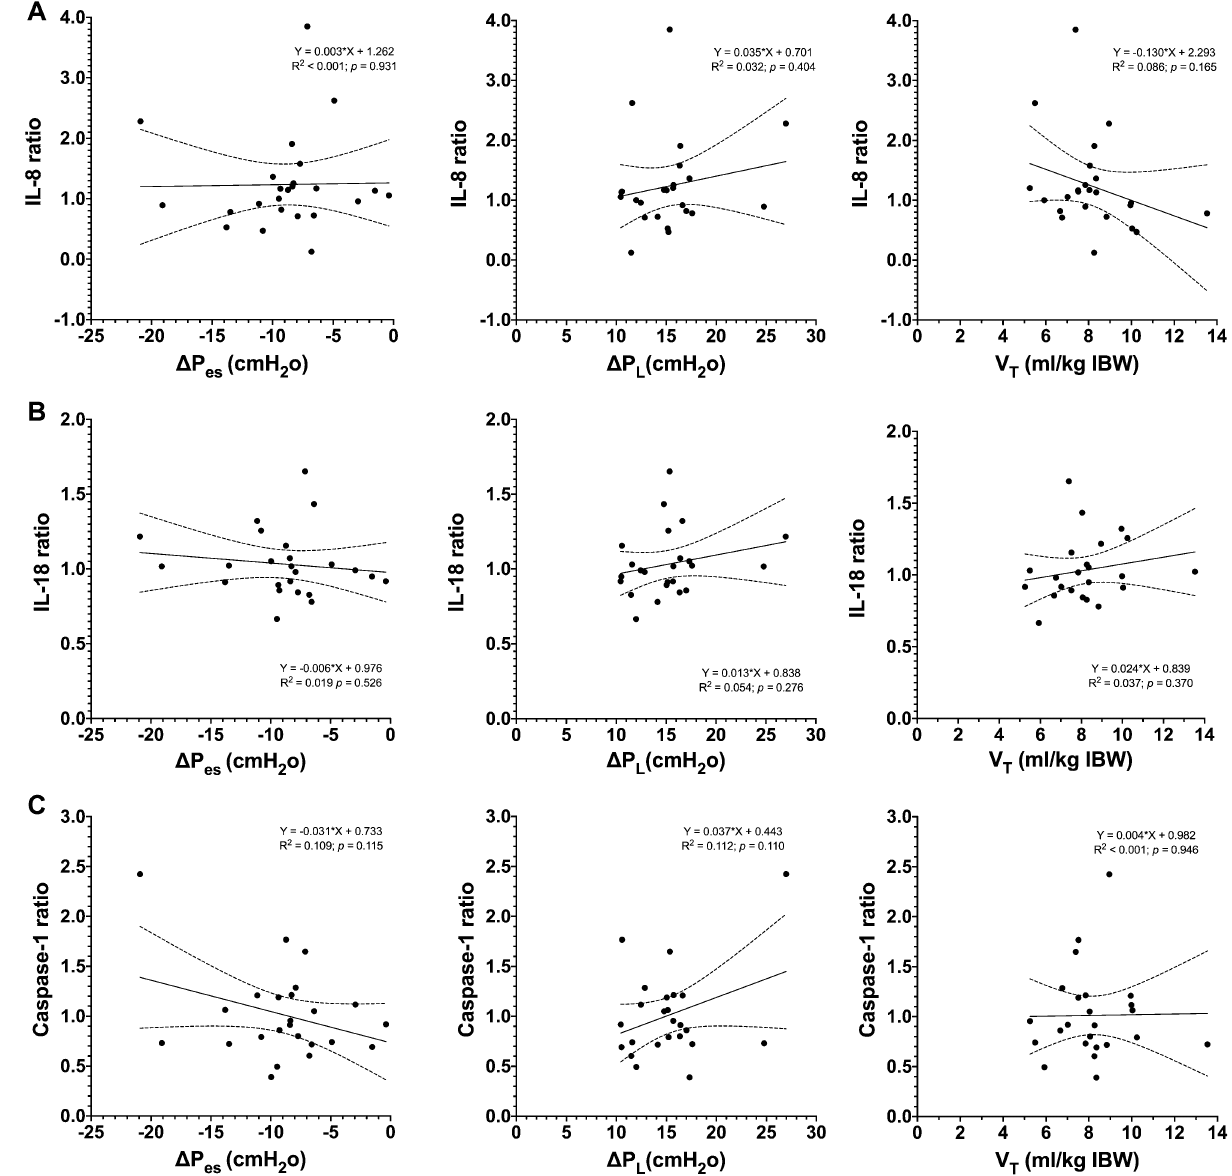
Figure 3. Scatter plots and regression analysis between ( A ) IL-8, ( B ) IL-18, ( C ) Caspase-1 ratios, and respiratory variables. Biomarker ratio [(biomarker at T 4 )/(biomarker at T 0 )] and the mean values by patient of ΔP es , ΔP L and V T , through the 4 h period of observation, were obtained for each patient ΔP es : mean of negative deflection of esophageal pressure (P es ) from the onset of inspiratory effort during the ventilatory cycle; ΔP L : mean of tidal change in transpulmonary pressure. Only the association between ΔP es and ΔP L and the pendelluft 2 0.202 and p- value = 0.047). Several patients presented pendelluft of higher 25 frequency was significant (R magnitude at lower than − 15 and 20 cmH 2 O of ΔP es and ΔP L ,